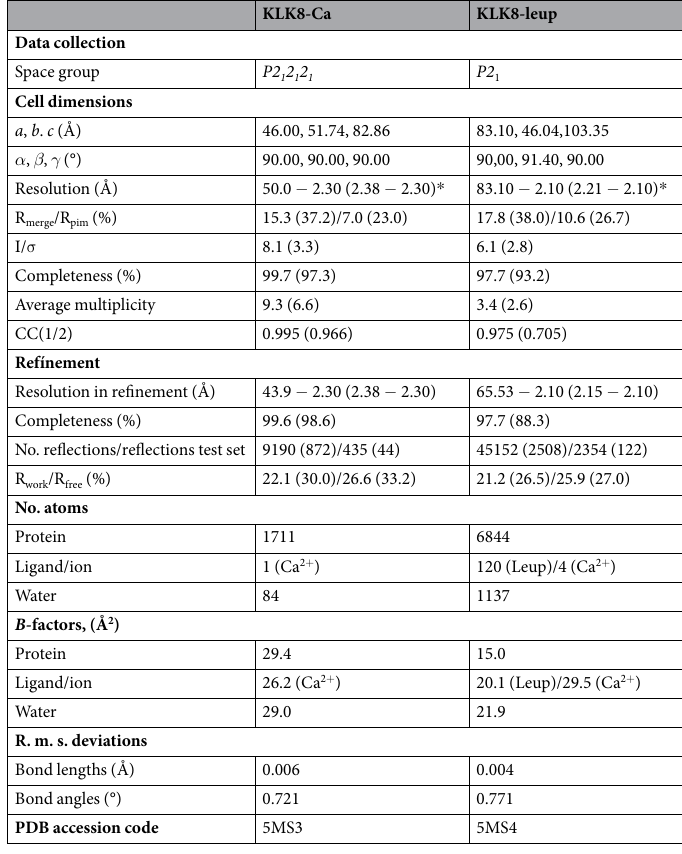
Table 2. Data collection and refinement statistics. * Highest resolution shell in